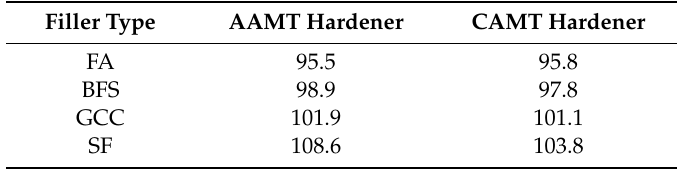
Table 8. Compressive strengths by filler and hardener type (unit: